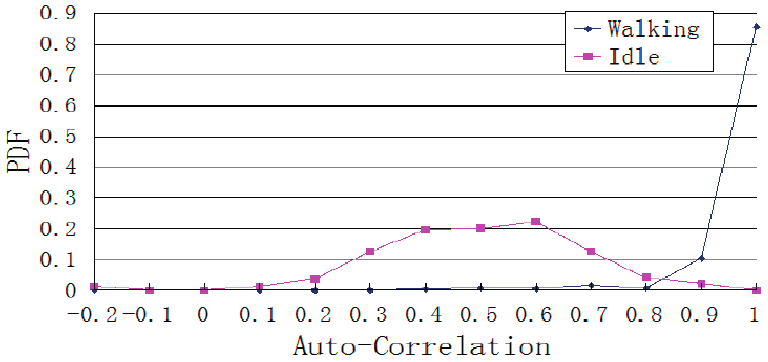
Figure 11. Distribution of auto-correlation during stationary and walking